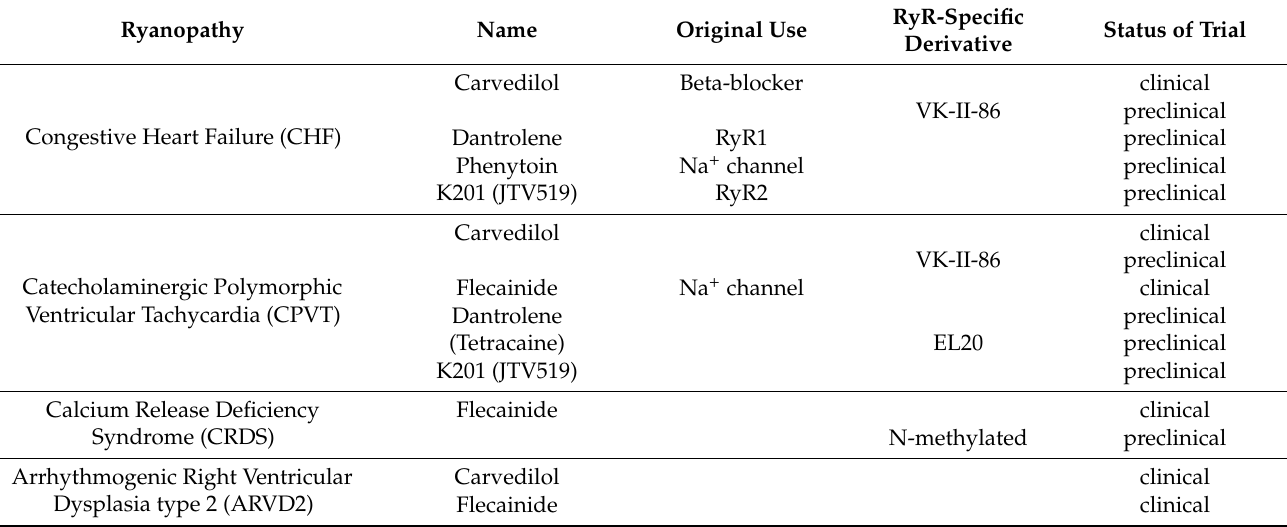
Table 1. RyR2 inhibitors used in